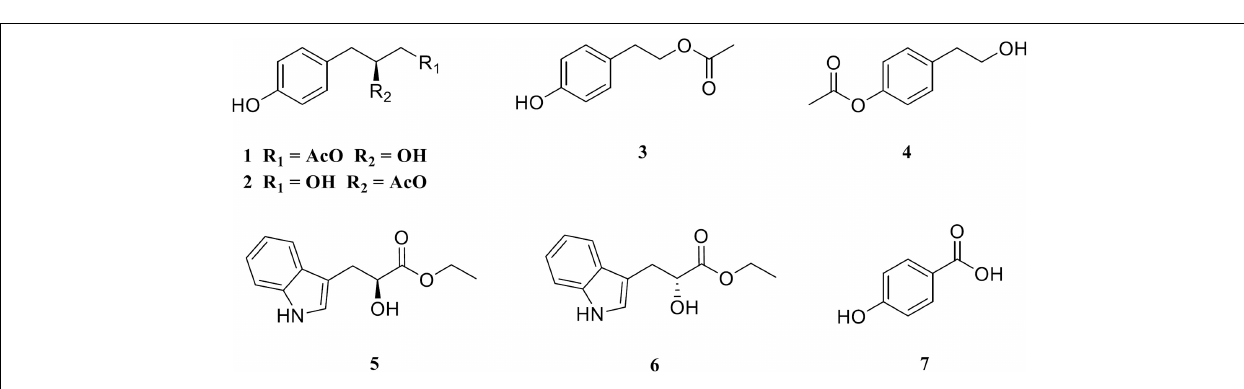
( Table 3 ). Five incomplete prophage remnants were detected on the chromosome, and the length of the prophages ranged from 8,264 to 28,169 bp ( Table 3